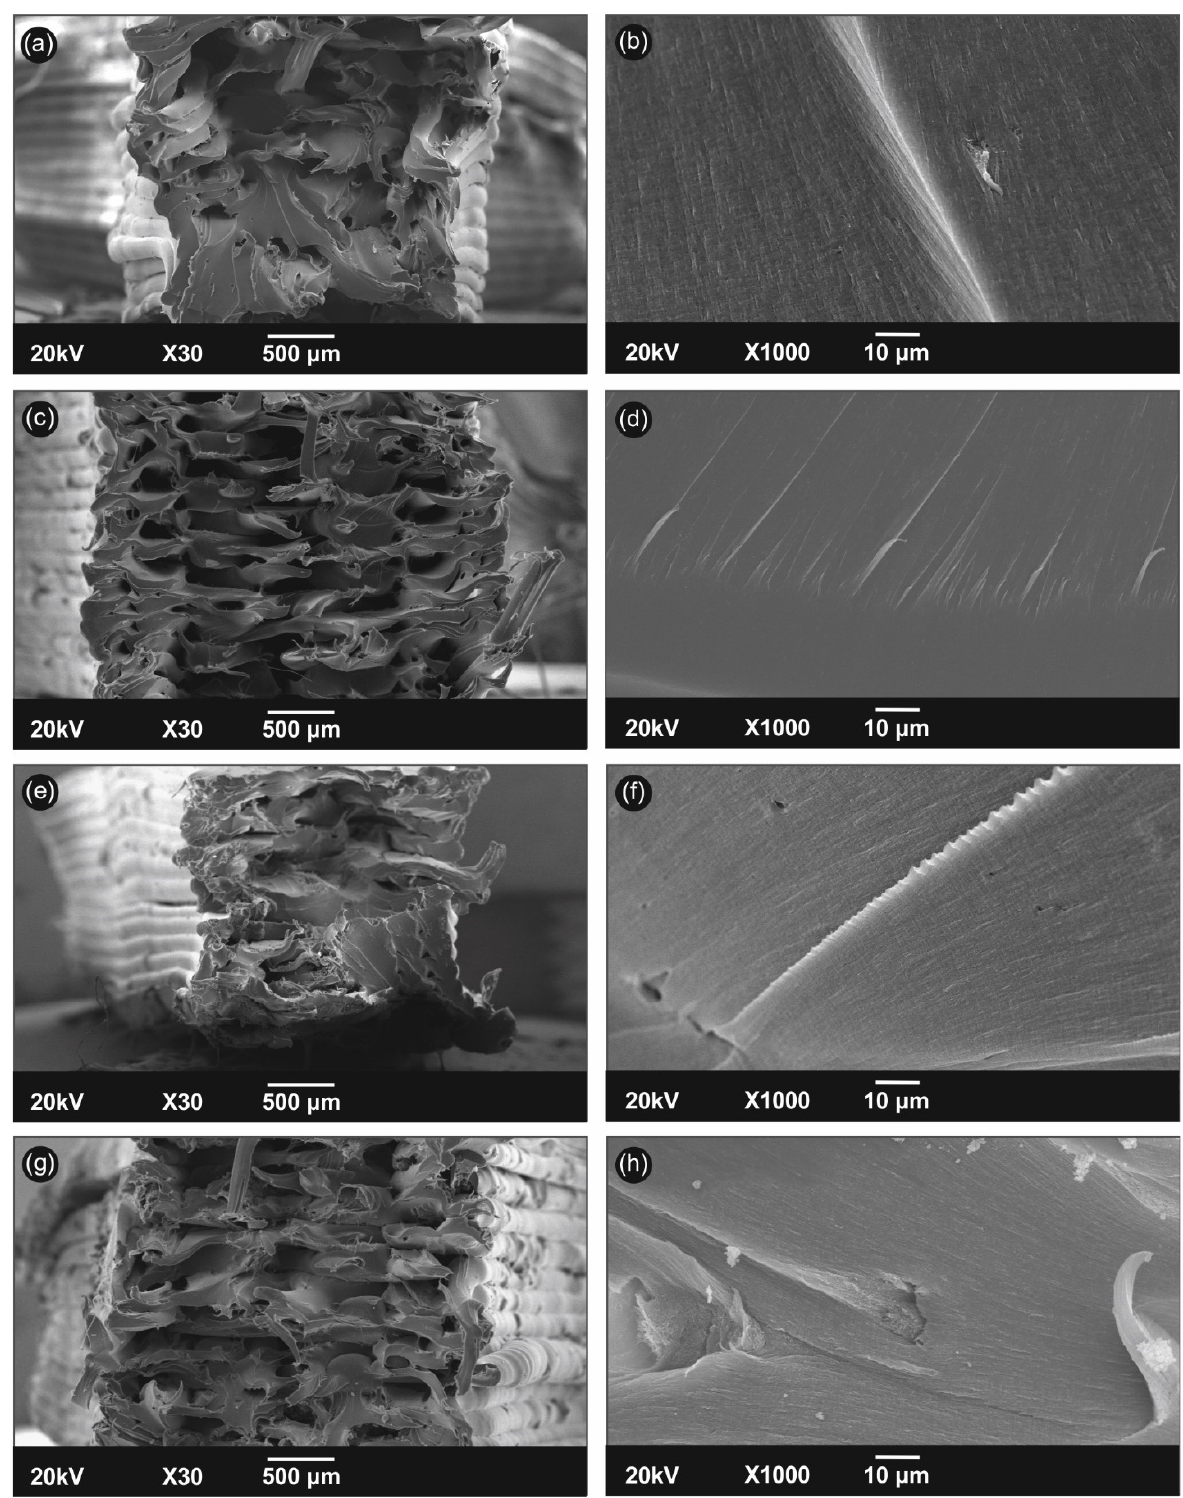
Figure 11. Fractured surface morphology of PA12/CNT 3D ‐ printed nanocomposites after tensile tests: neat PA12 ( a , b ) compared to 2.5 wt.% ( c , d ), 5.0 wt.% ( e , f ), and 10.0 wt.% ( g , h ) filler loading. More specifically, neat PA12 (Figure 10a,b), compared to 2.5 wt.% (Figure 10c,d), 5.0 wt.% (Figure 10e,f), and 10.0 wt.% (Figure 10g,h) CNT filler loadings, are depicted at two different magnifications. The low magnification images show relatively similar character ‐